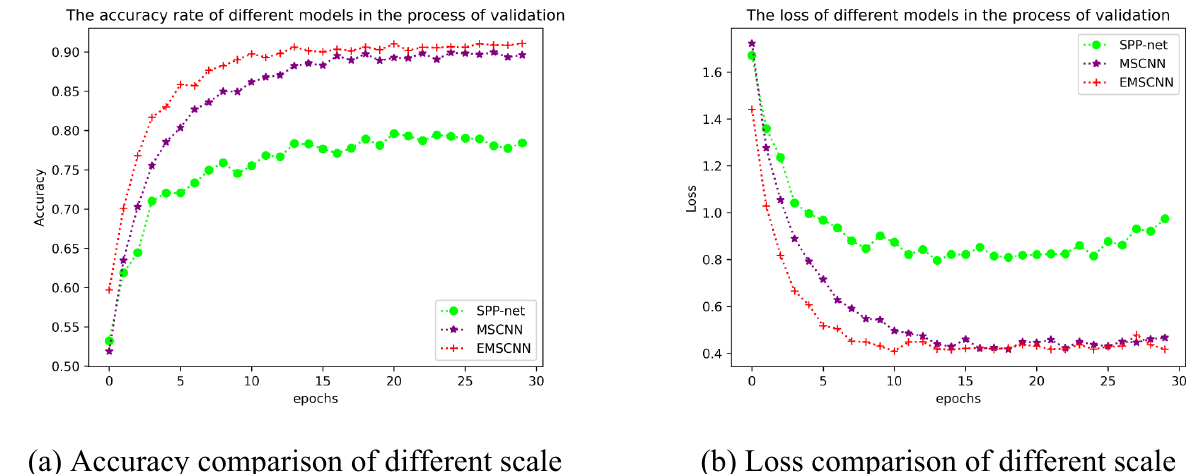
Figure 11. Comparison of MSCNN, EMSCNN and SPP-net in the validation